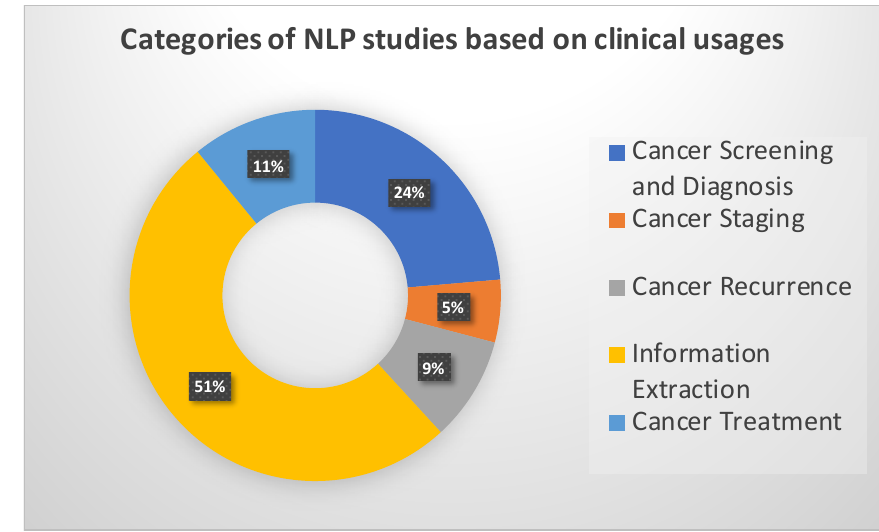
Figure 1. The percentages of studies in each category based on clinical usage.